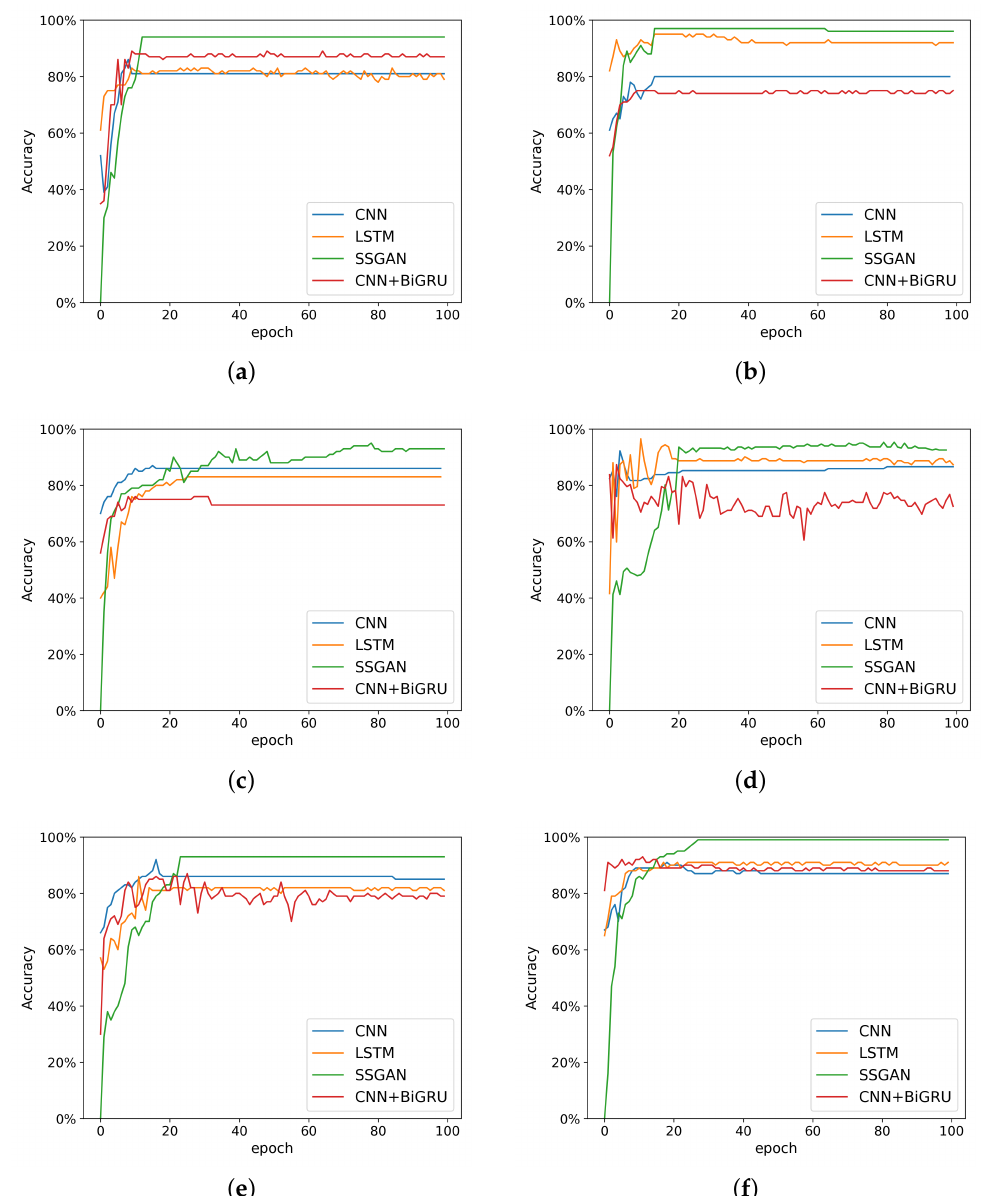
Figure 9. Accuracy of the test sets. ( a ) Accuracy of test set A; ( b ) Accuracy of test set B; ( c ) Accuracy of test set C; ( d ) Accuracy of test set D; ( e ) Accuracy of test set E; ( f ) Accuracy of test set